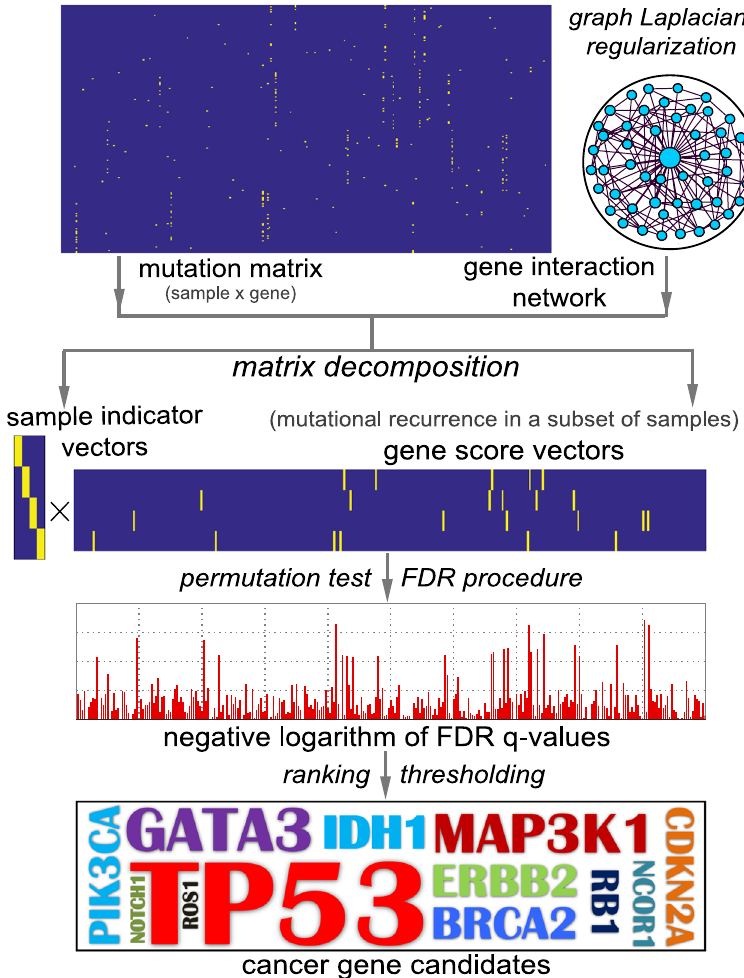
Figure 1. Schematic diagram of mCGfinder, which is a matrix decomposition method integrated with network information. It decomposes the mutation matrix as the matrix multiplication of the sample indicator vectors and the transpose of gene score vectors. The different components in the results of mCGfinder are regarded as the outer products of different sample indicator vectors and their related gene score vectors, where the summation of the components is an approximation of the mutation matrix. Graph Laplacian regularization is used to incorporate information of gene interaction network into mCGfinder. After the matrix decomposition procedure, the mutational recurrence of genes in different subsets of samples can be measured from the gene score vectors of the related component, and the related subsets samples of the component are indicated by the sample indicator vectors. Through permutation test and false discovery rate (FDR) control, mutated cancer gene candidates can be identified by thresholding FDR q-values of the